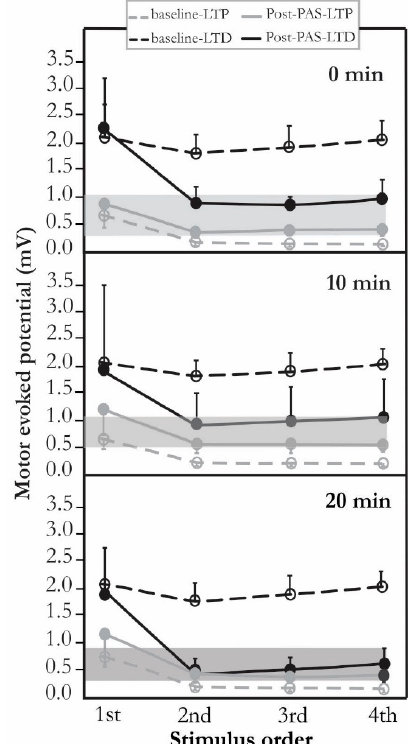
Figure A2. RS at 0, 10, and 20 min after the induction of short-term plasticity with PAS (post-PAS). Effects of LTP/LTD-like plasticity were measured with respect to “baseline” pre-intervention neural activity. Irrespective of the dynamic state of RS, the brain shows a tendency towards a suppressed amplitude level of the second to the fourth MEPs within trials upon repetition of the stimulus. This static status was maintained within a narrow range in two groups after